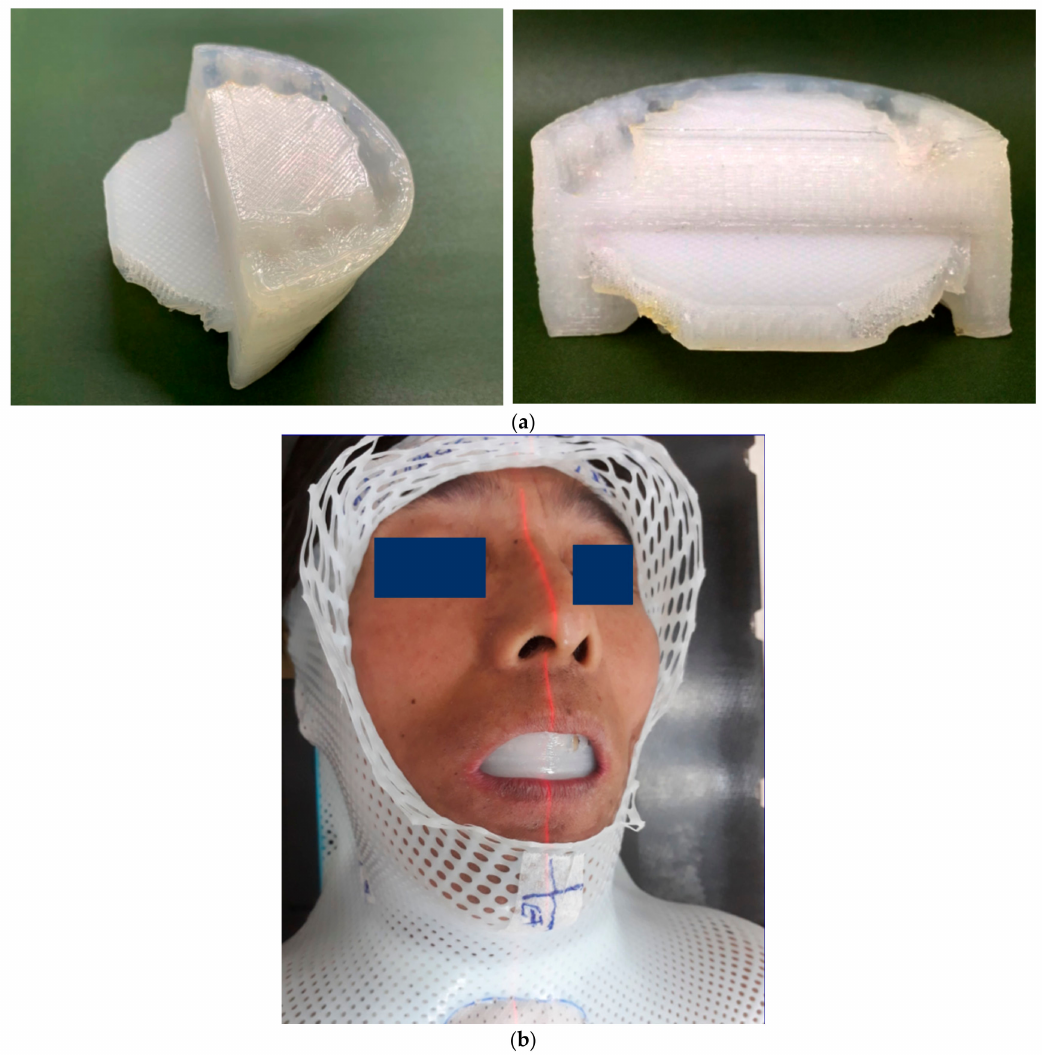
Figure 2. Shape and clinical use of the silicone 3D-printing bite block. The silicone 3D printing bite block exhibited superior mechanical and physical properties, such as good elasticity, adequate rigidity, heat and cold resistance, and great biocompatibility. ( a ) The shapes of the occlusal surface and tongue depressor were integrated into one piece. ( b ) The patient tolerated the silicone 3D printed bite block well in the CT simulation and RT